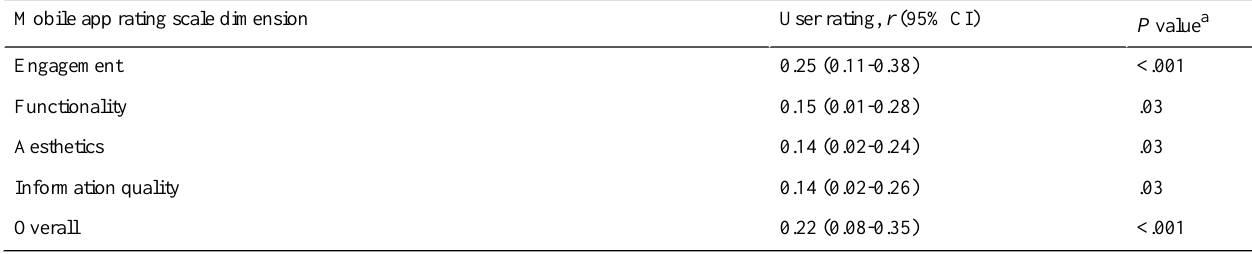
Table 2. Correlation between mobile app rating scale and user rating.